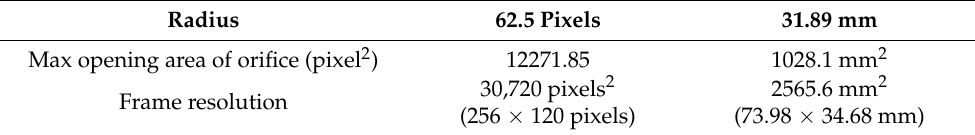
Table 3. Relevant measurements in pixels and the corresponding metric